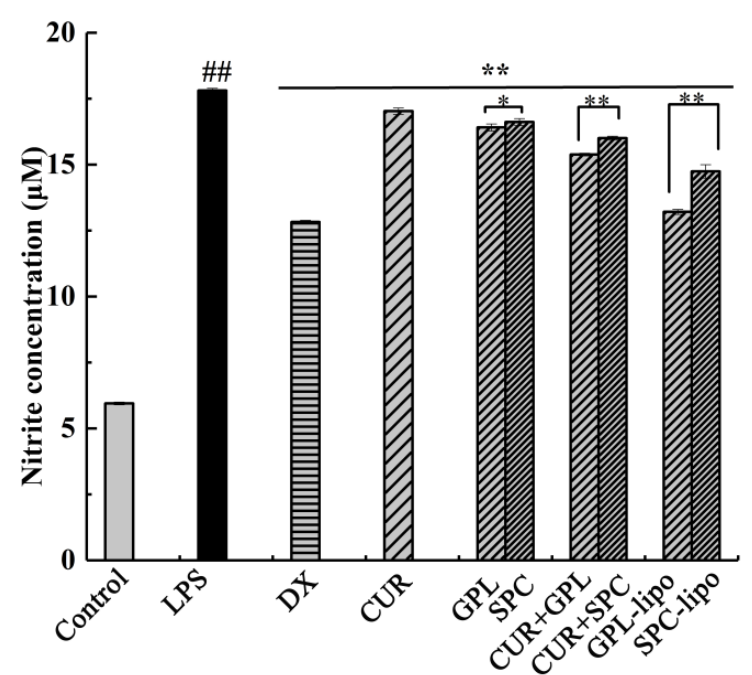
Figure 4. Effects of DX (20 µ g/mL), GPL (50 µ g/mL), CUR (1 µ g/mL), CUR (1 µ g/mL) and GPL/SPC (50 µ g/mL) co-treatment and liposome (50 µ g/mL, using phospholipid concentration as standard) on the NO level in RAW264.7 cells. Data are expressed as mean ± SD ( n = 4) and multiple comparisons were done using one-way ANOVA analysis. ## p < 0.01 versus control group; * p < 0.05; ** p < 0.01 versus the LPS group. Abbreviations: DX-dexamethasone, GPL-golden pompano head phospholipids, SPC-soybean lecithin, CUR-curcumin, NO- nitric oxide, LPS-lipopolysaccharide.